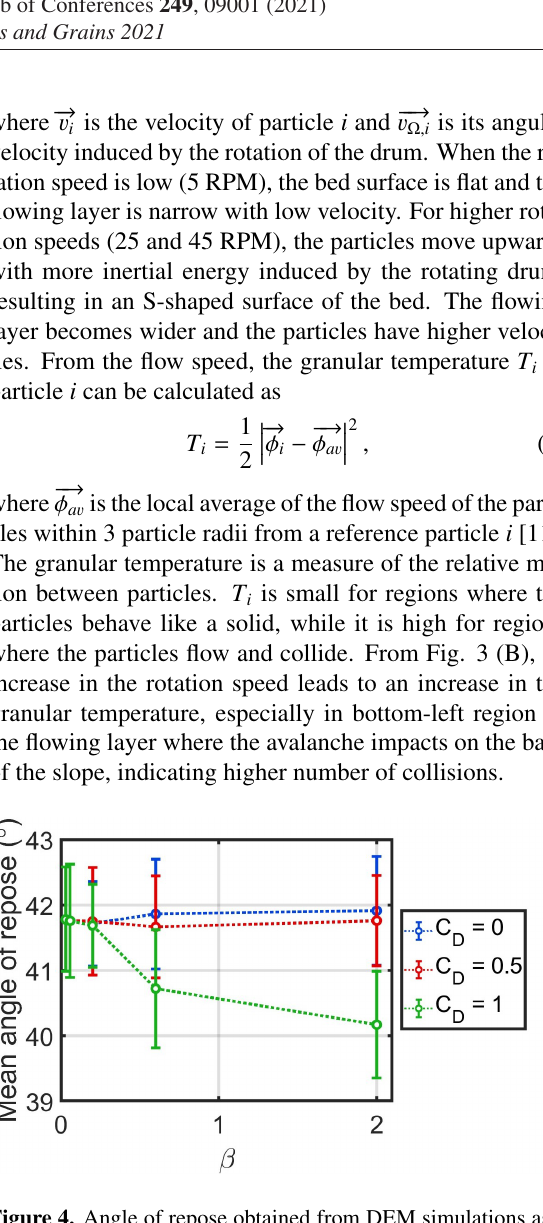
Figure 4. Angle of repose obtained from DEM simulations as a function of β for di ff erent values of C D .